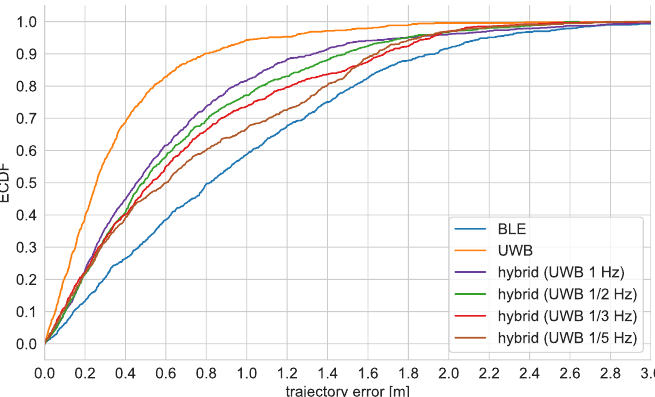
Figure 13. Empirical cumulative distribution function for trajectory